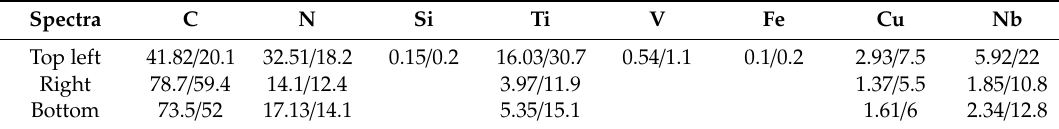
Table 2. EDS chemical composition measurements from precipitates in Figure 2b (at% / wt%).